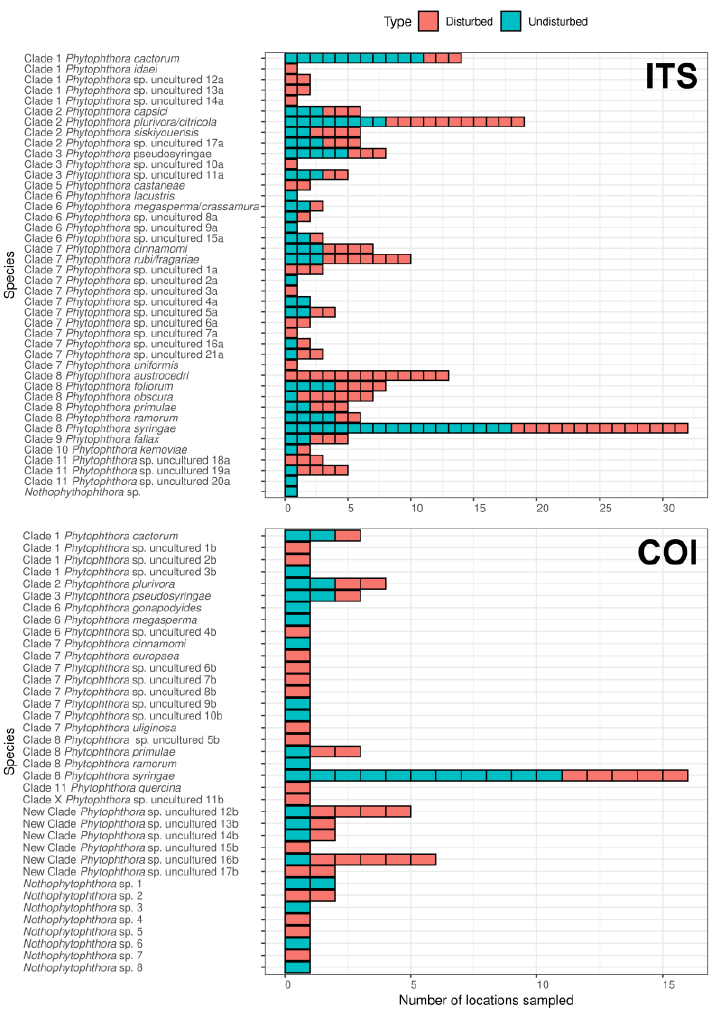
Figure 2. Occurrence of Phytophthora spp. and Nothophytophthora spp. in British soils in the differ- ent location sampled in “disturbed” or “undisturbed” sites determined based on next-generation sequencing (NGS) analyses of the ITS and COI regions.